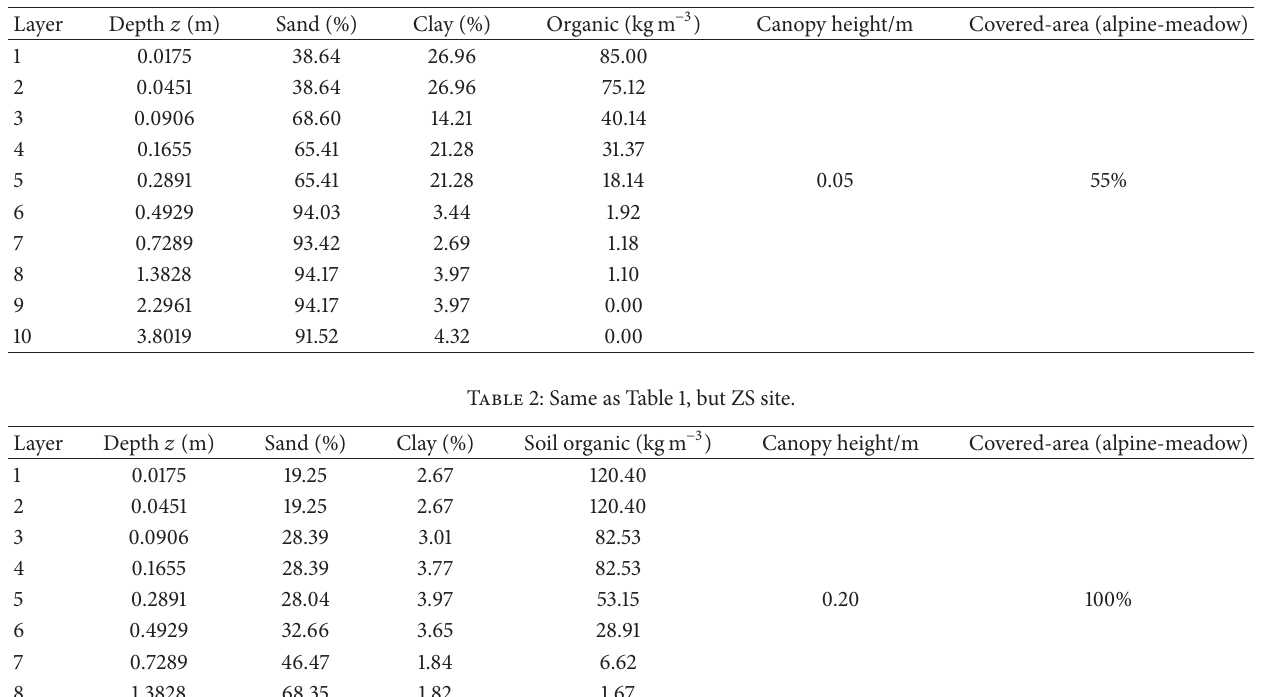
Table 1: Values of soil parameters for different soil layers at GS site.